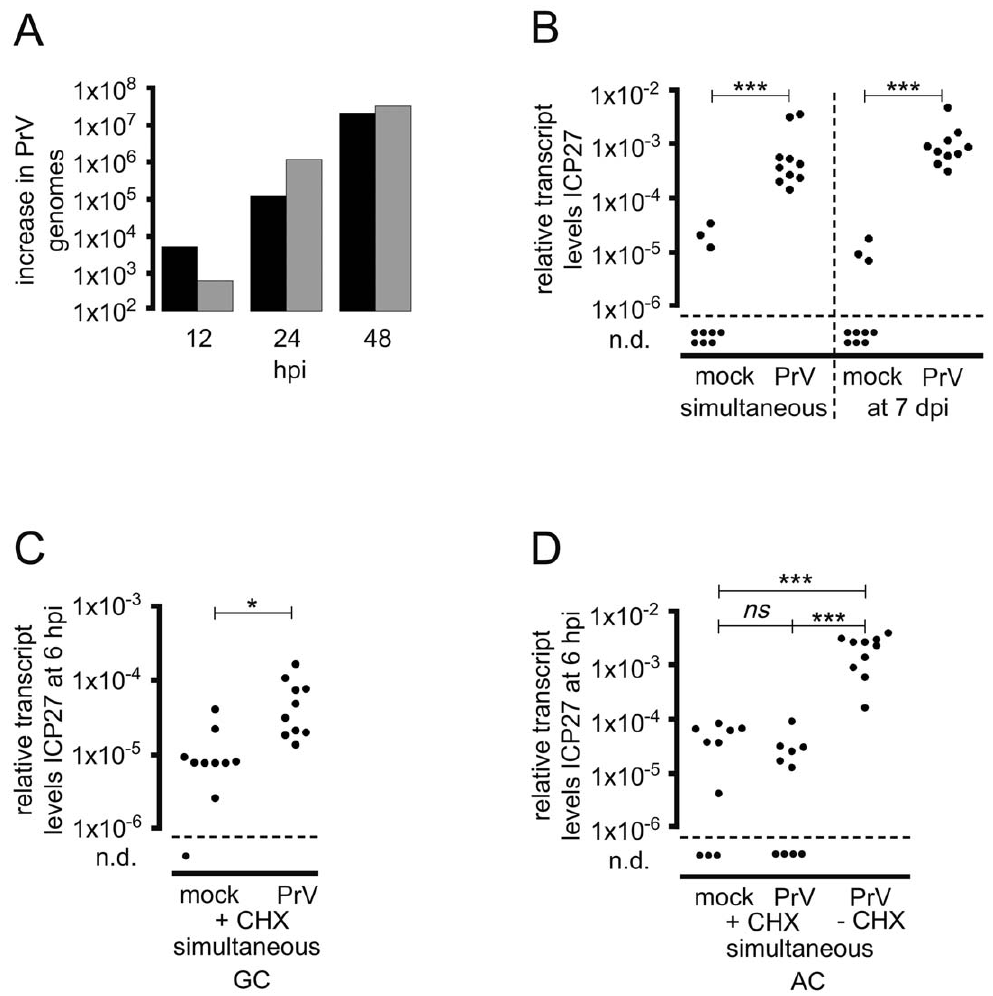
Figure 8. Transcriptional transactivation of HSV-1 IE gene expression by PrV helper virus. (A) Replication of PrV in TGEs. Groups of three TGEs were either infected in the AC with 5 6 10 6 pfu of PrV-KaDgGgfp (grey bars) or in the GC with 10 4 pfu of PrV-KaDgGgfp (black bars), and harvested at the time points indicated. DNA extracts were pooled, genome levels were determined by qPCR, and the increase in genome levels relative to 1 hpi was calculated. (B) Transcriptional transactivation of HSV-1 by PrV infection of the GC. TGEs were infected in the AC with 5 6 10 6 pfu of HSV-1 CMV-IEproEGFP, and infected either simultaneously or at 7 dpi in the GC with 5 6 10 6 pfu of PrV-KaDgGgfp. Replication of PrV was suppressed by the addition of 50 m g/ml ACV to the media. Cultures were harvested at 6 hpi after the addition of PrV to the GC, and relative ICP27 transcript levels were determined. Cultures not infected with helper virus served as controls. The statistical significances of differences in the transcript levels are indicated (simultaneous infection, P , 0.0001; addition of PrV at 7 dpi, P , 0.0001; unpaired t test with Welch correction). (C) Transcriptional transactivation of HSV-1 by co-infection of the GC with PrV in the presence of CHX. TGEs were infected in the AC with 5 6 10 6 pfu of HSV-1 17 CMV- IEproEGFP in the presence of CHX and either co-infected in the GC with 5 6 10 6 pfu of PrV-Ka D gGgfp or mock-treated. Cultures were harvested at 6 hpi and ICP27 transcript levels normalized to b -actin transcripts were determined. The statistical significances of differences in the mean relative transcript levels are indicated ( P =0.0186, unpaired t test with Welch correction). (D) Transcriptional transactivation of HSV-1 by co-infection of the AC with PrV. TGEs were infected in the AC with 2.5 6 10 6 pfu of HSV-1 17 syn + in the presence or absence of CHX and co-infected in the AC with 2.5 6 10 6 pfu of PrV-Ka D gGgfp or mock-treated as indicated. Cultures were harvested at 6 hpi and ICP27 transcript levels normalized to b -actin transcripts were determined. The statistical significances of differences in the mean relative transcript levels are indicated (mock + CHX vs. PrV + CHX, P . 0.999; mock + CHX vs. PrV 2 CHX, P , 0.0001; PrV + CHX vs. PrV 2 CHX, P , 0.0001; Mann-Whitney test), ns (not